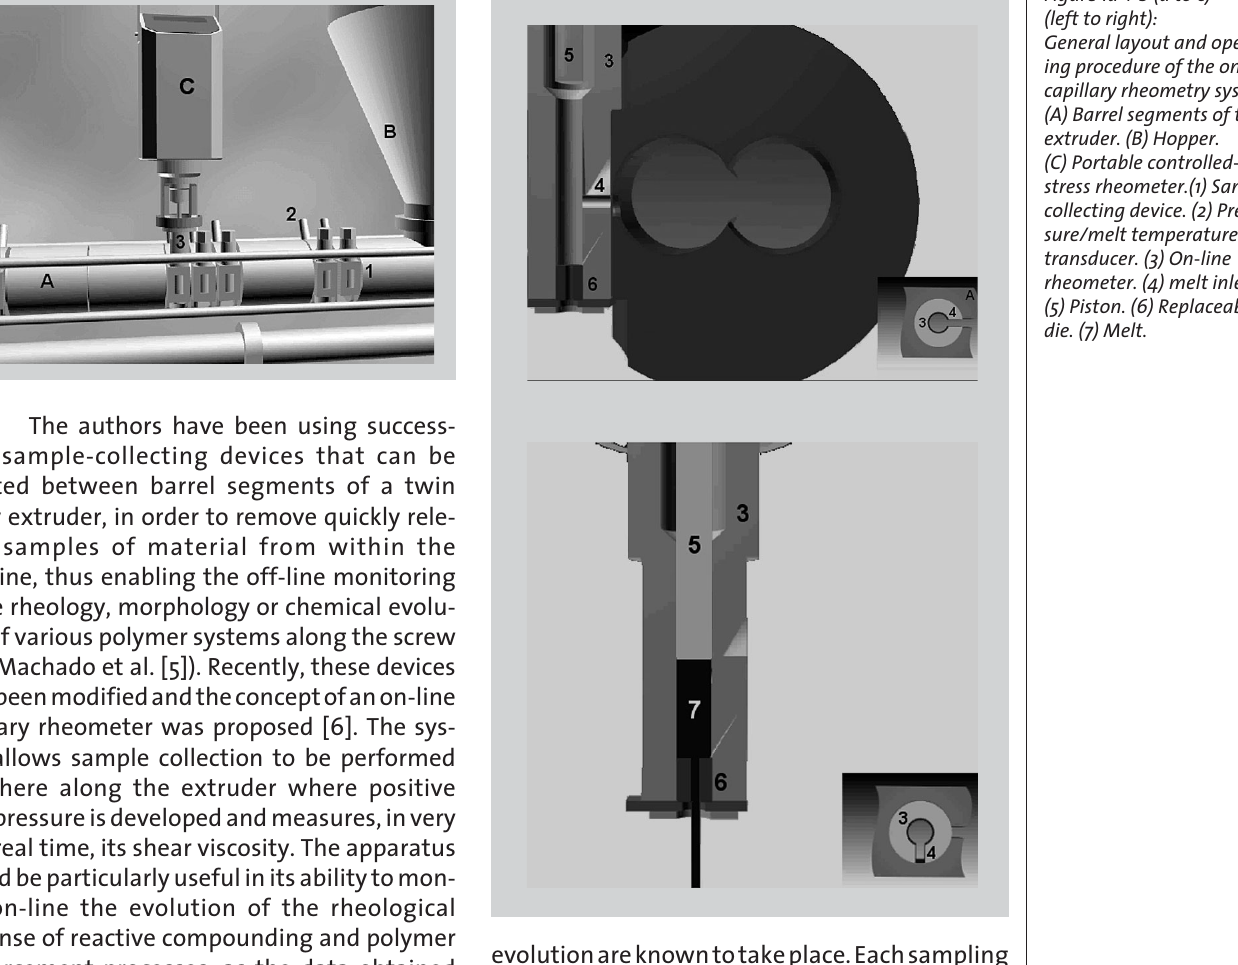
Figure 1a + b (a to c) (left to right): General layout and operat- ing procedure of the on-line capillary rheometry system. (A) Barrel segments of the extruder. (B) Hopper. (C) Portable controlled- stress rheometer.(1) Sample- collecting device. (2) Pres- sure/melt temperature transducer. (3) On-line rheometer. (4) melt inlet. (5) Piston. (6) Replaceable die. (7)